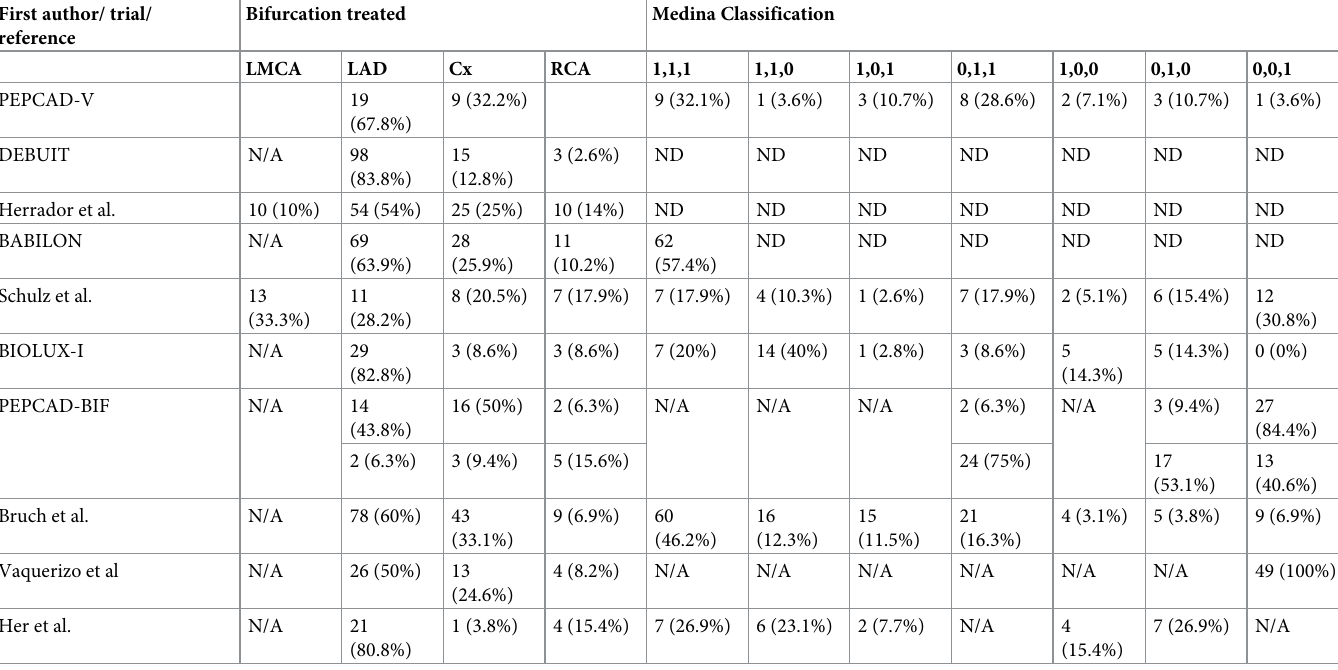
PEPCAD-BIF (2016) randomised patients (n = 64) to either DCB or POBA only approach for bifurcation lesions that did not incorporate proximal main branch disease (i.e. Medina 0,1,0, 0,0,1 or 0,1,1). It incorporated largely small vessels (mean vessel diameter 2.4mm). This showed a statistically significant improvement in late lumen loss favouring the DCB arm (0.13 v 0.51, p = 0.013) [20]. As the first DCB only randomised trial, this showed promising results for the use of DCB only bifurcation.